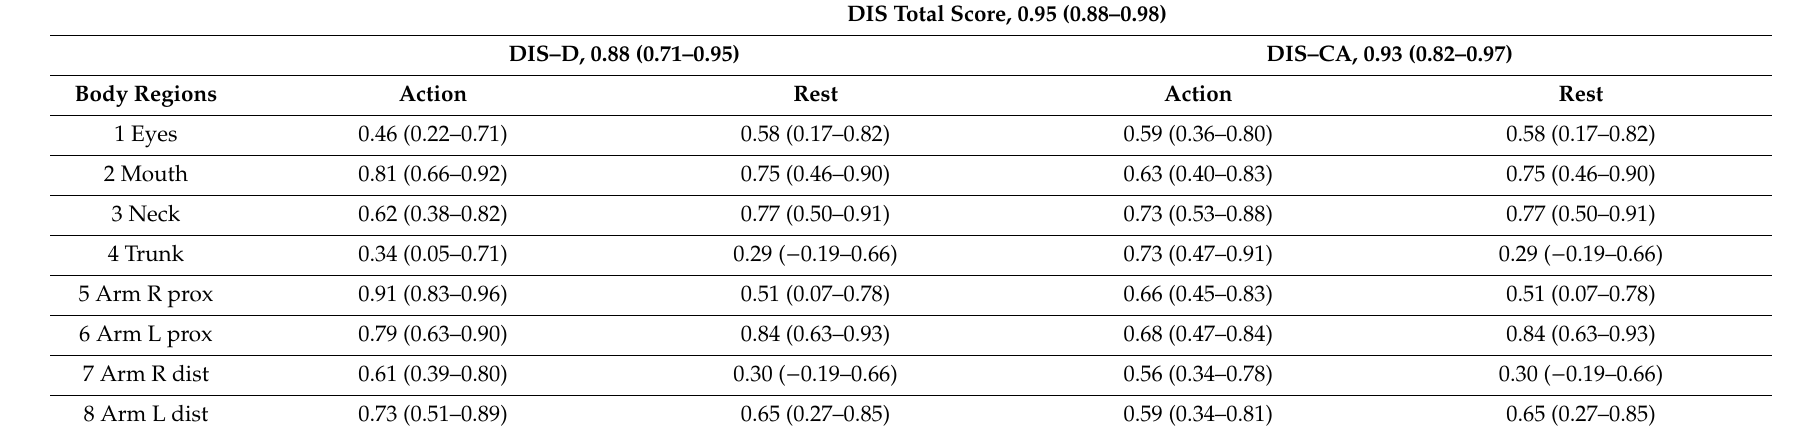
Table 2. Test-retest reliability, intraclass correlation coe ffi cient (ICC) values and confidence intervals [CIs] of the DIS, n =